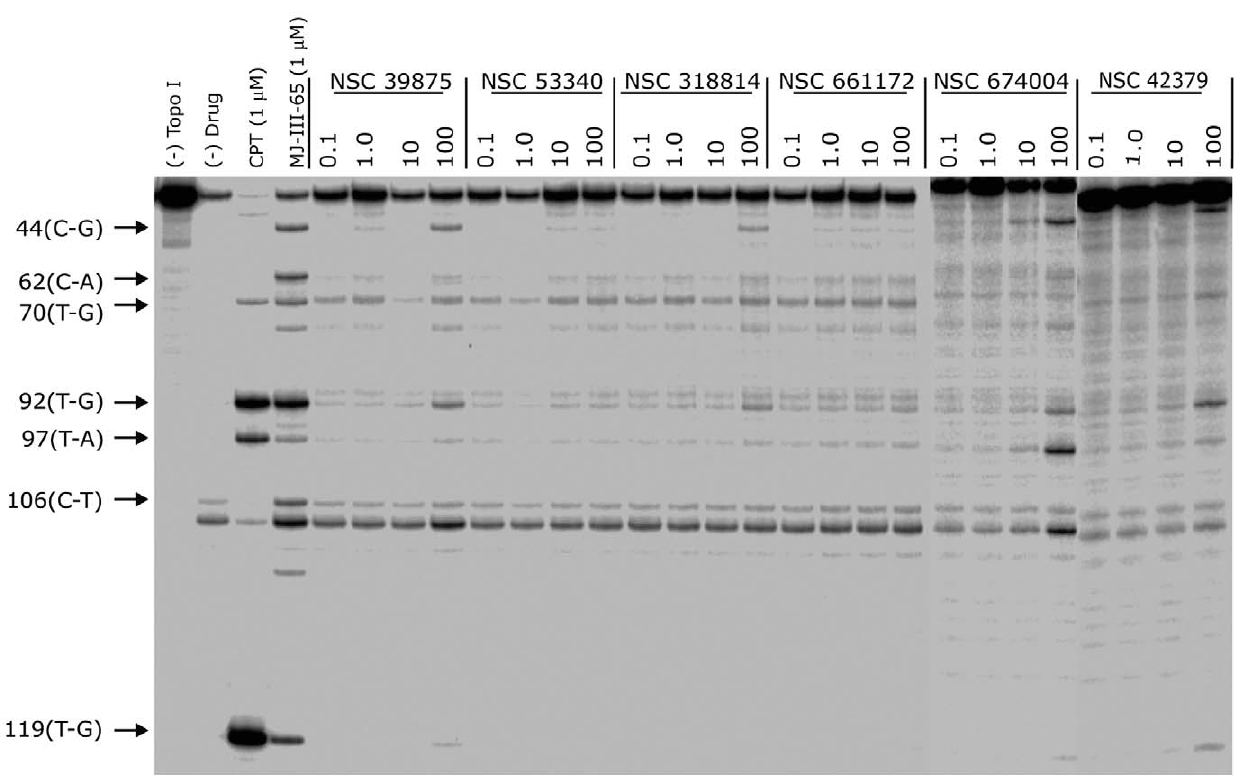
Figure 7. Top1-mediated DNA cleavage induced by tested compounds. (lane 1) DNA alone; (lane 2) Top1 alone; (lane 3) camptothecin, 1 m M; (lane 4) MJ-III-65, 1 m M; (lanes 5–28) Top1 + NCI compounds indicated at 0.1, 1, 10 and 100 m M concentrations, respectively. The numbers on the left and arrows indicate cleavage site positions.